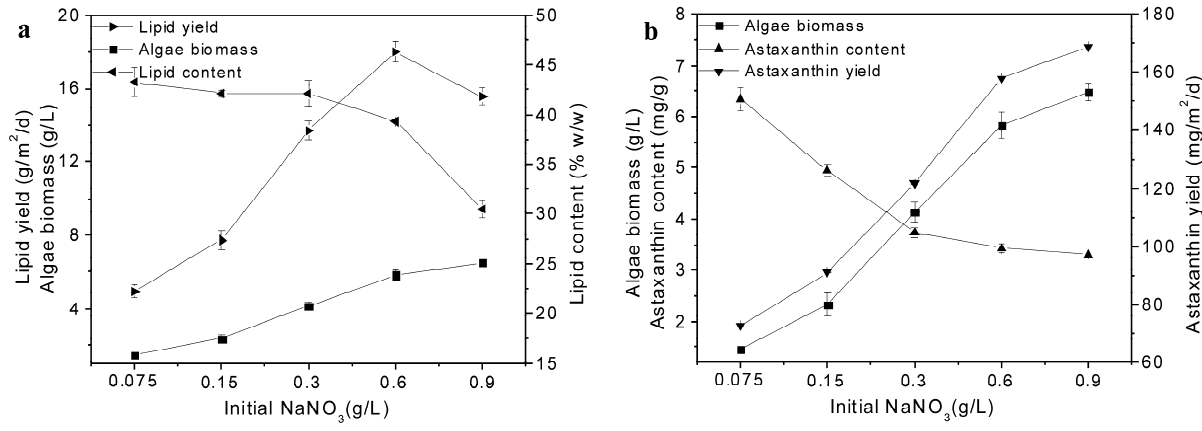
Figure 6. Lipid ( a ) and astaxanthin ( b ) accumulation of Coelastrum sp. HA-1 at different initial NaNO concentrations after cultivation for 24 days. 3